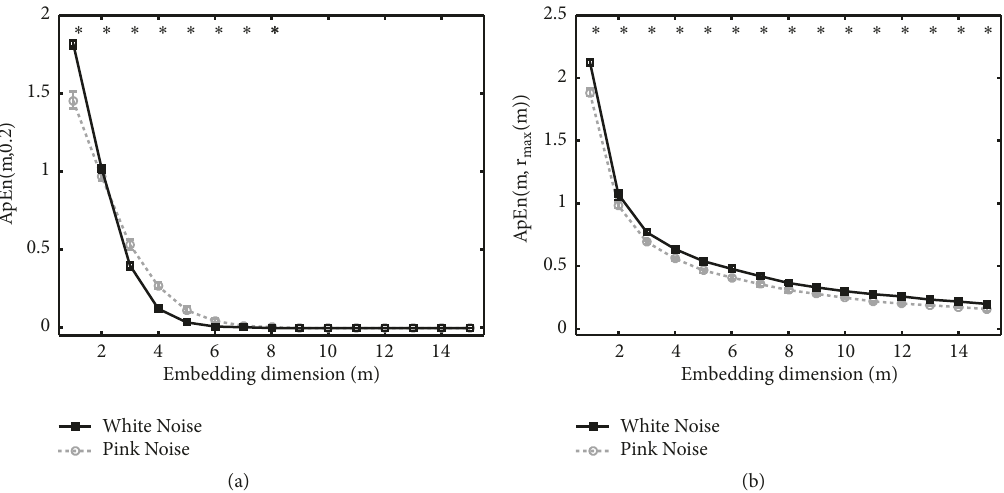
(2)) , ApEn(6,r (6)) , r (2) , and r (6) max max max max